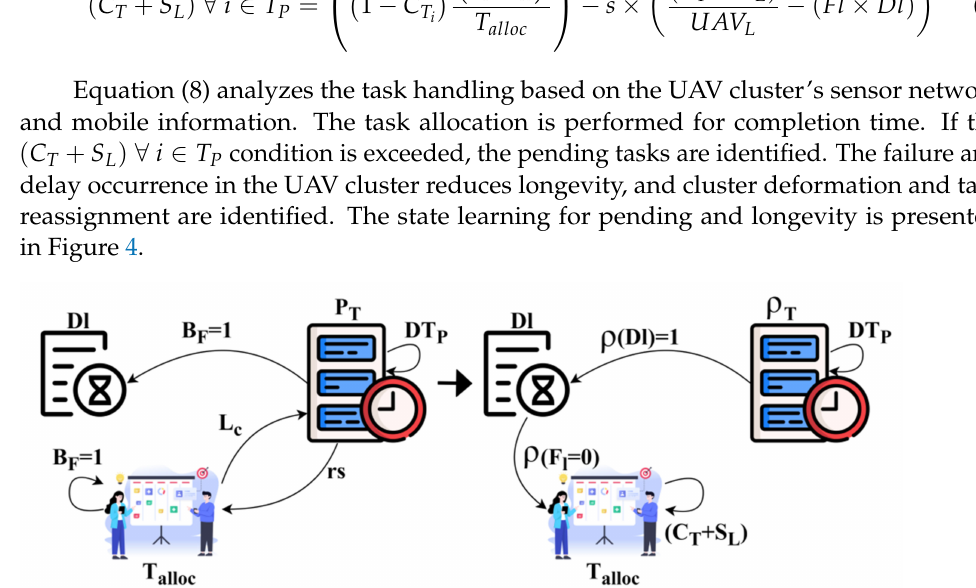
Figure 4. State learning for pending and